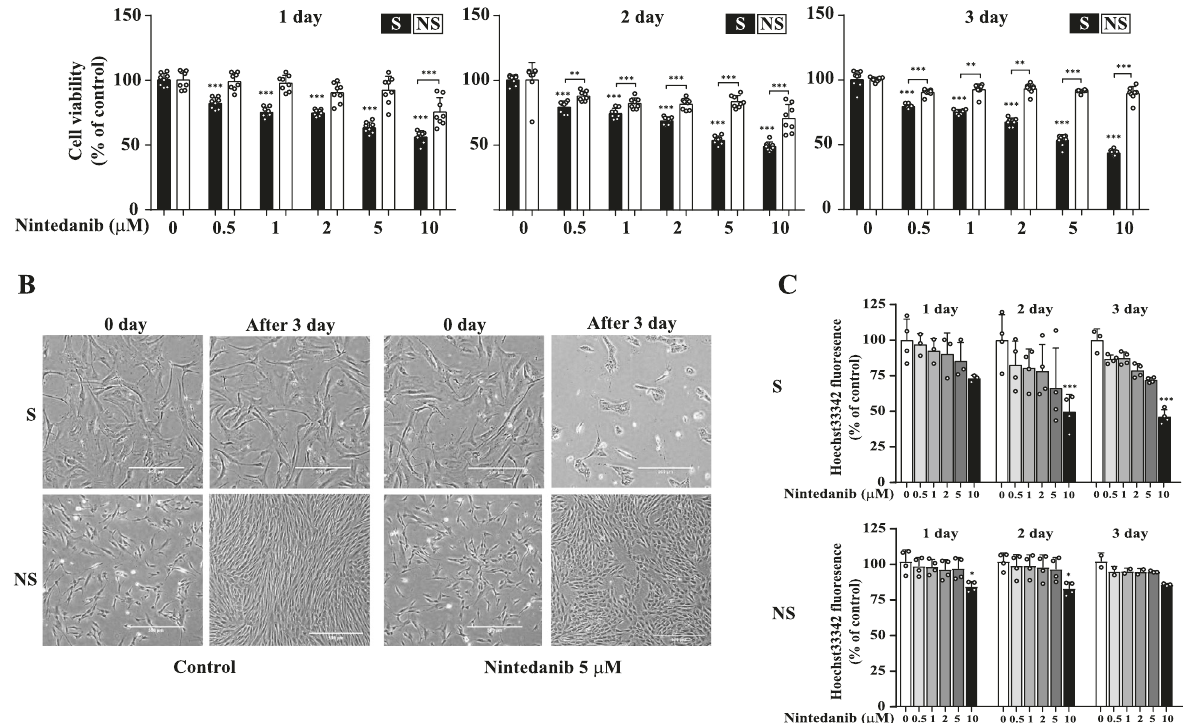
Fig. 1 Nintedanib reduces the viability of senescent HDFs. A Senescent (S) HDFs and nonsenescent (NS) HDFs were treated with nintedanib (0.5, 1, 2, 5, and 10 μ M) for 1, 2, or 3 days, and then CCK-8 assays were performed to assess cell viability. n = 8. B Cell morphological changes after three days of treatment with DMSO (control) or nintedanib (5 μ M). Senescent (S) HDFs (5 × 10 4 cells per well) and nonsenescent (NS) HDFs (8 × 10 4 cells per well) were separately plated in 6-well plates. Images were randomly captured by inverted microscopy. Scale bar, 500 μ m. C Senescent (S) HDFs and nonsenescent (NS) HDFs were treated with DMSO or nintedanib (0.5, 1, 2, 5, and 10 μ M) for three days, and Hoechst 33342 staining was then performed to investigate cell growth. The data normalized to those for DMSO-treated cells are shown as